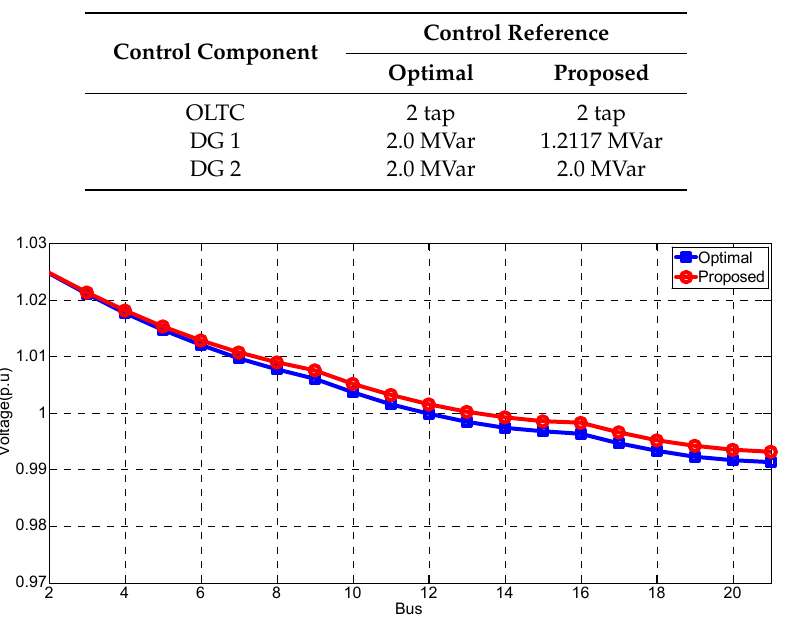
Table 2. Simulation results of the tap position and reactive power for nominal voltage in case 1.